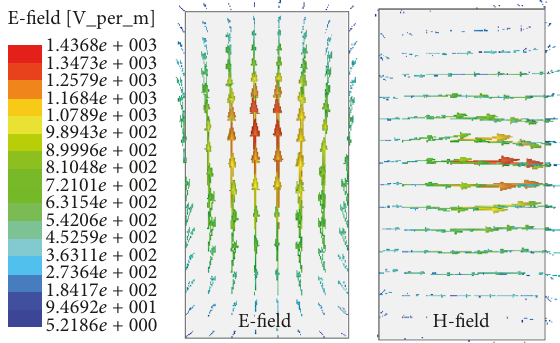
Figure 7: It illustrates the effect of air-gap ( 𝑎 1 ).